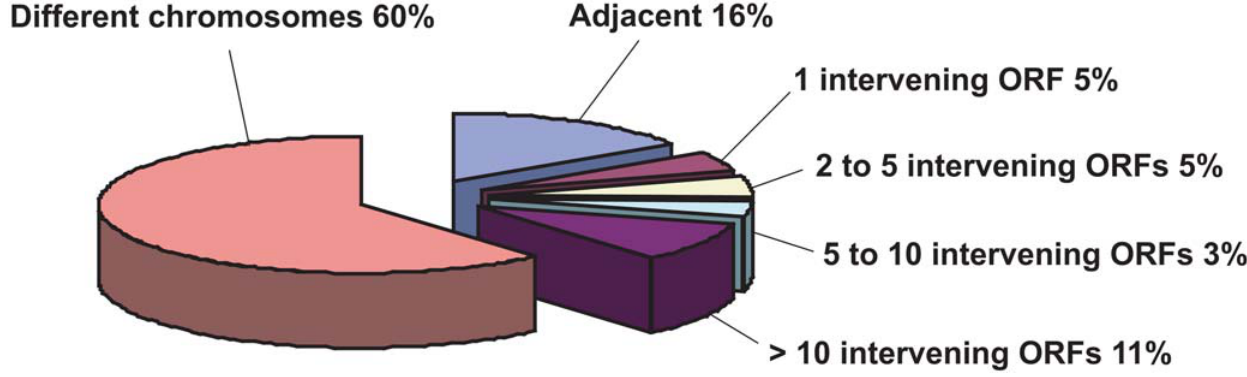
Figure 1. Percentage of gene order conservation between E.bieneusiand E.cuniculi. Each category displays the percentage of gene pairs in E. bieneusi that are adjacent, close neighbours, or nonsyntenic in E. cuniculi .